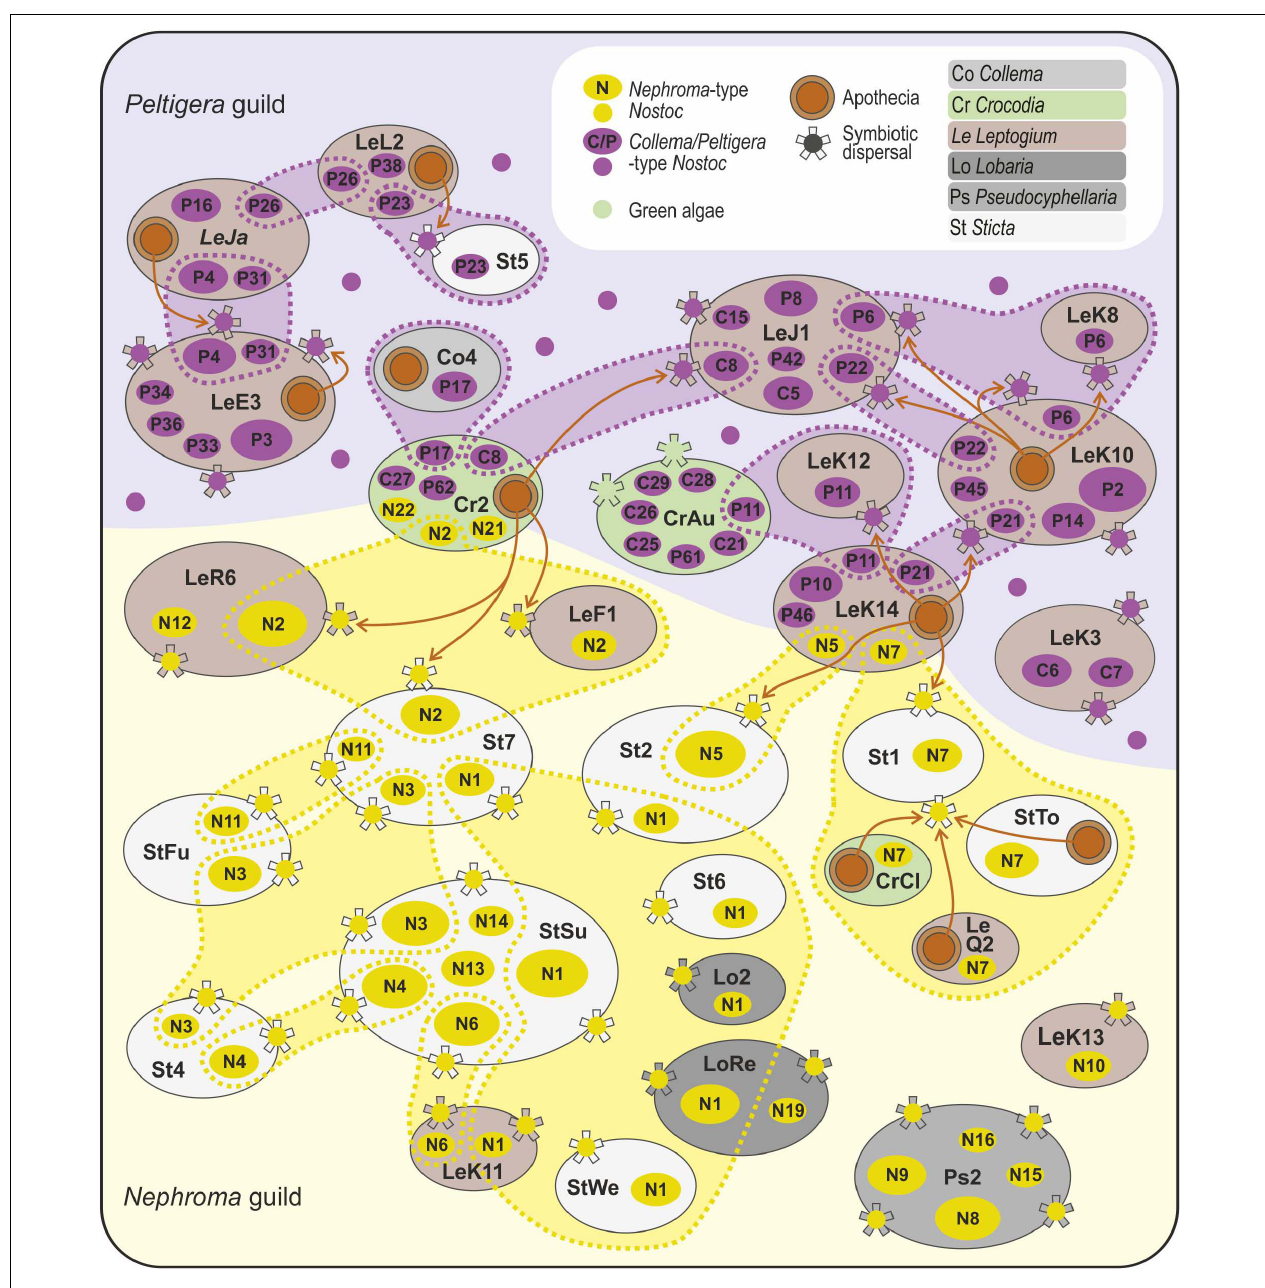
FIGURE 3 | Schematic presentation of potential photobiont-mediated guild interactions among symbionts of Peltigeralean lichens in the Taita Hills, Kenya. The figure includes selected representatives of 74 different lichen species/OTUs identified in the study area. Each large oval represents a mycobiont taxon, the size proportional to the number of analyzed specimens and the color revealing generic affiliation (see legend); explanations for the species codes are available in Supplementary Table 2 . The small ovals inside the mycobionts show the Nostoc variants identified from each mycobiont taxon ( Nephroma -type cyanobionts in yellow, Collema / Peltigera -type cyanobionts in purple). The cyanobionts shared by several mycobiont species are enclosed with a dashed line. The observed reproductive mode of each lichen species is shown (apothecia as brown circles, symbiotic propagules as “stars”). The brown arrows indicate possible links between core species and fringe